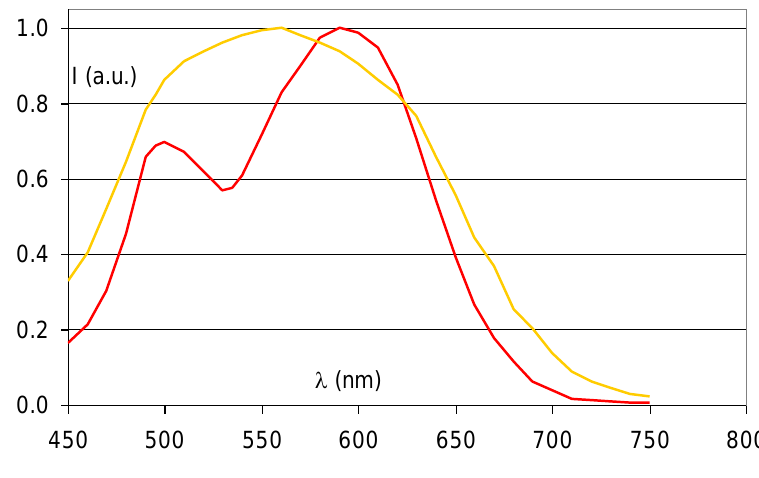
Figure 14. Stimulation spectrum of Ba BaFBr:Eu 2+ (red).